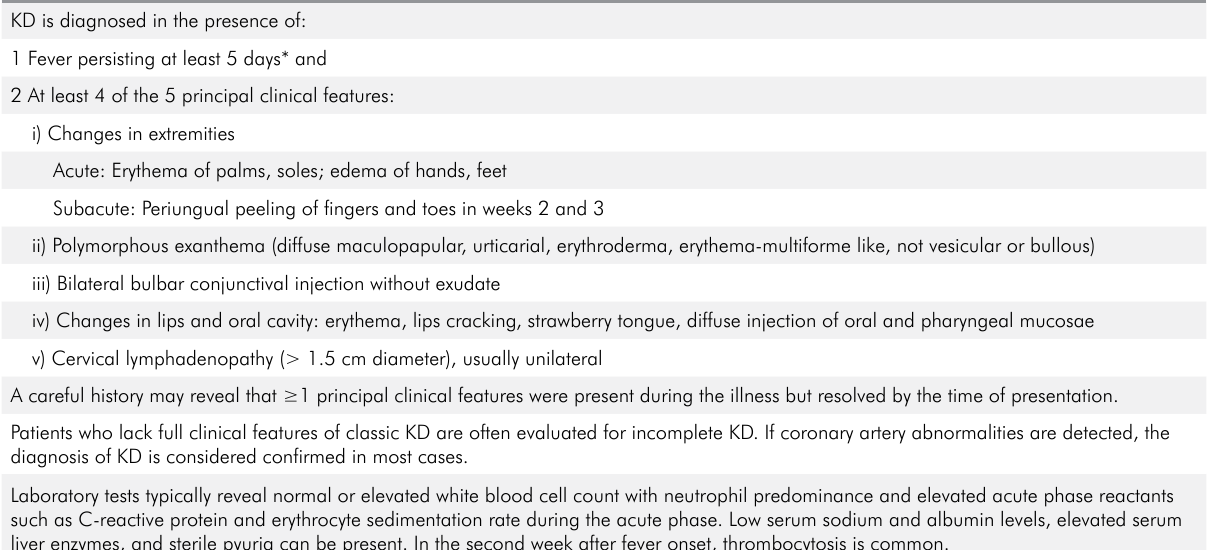
Table 2. Guidelines for the diagnosis of Kawasaki disease from American Heart Association (AHA, 2017). 15,16 KD is diagnosed in the presence